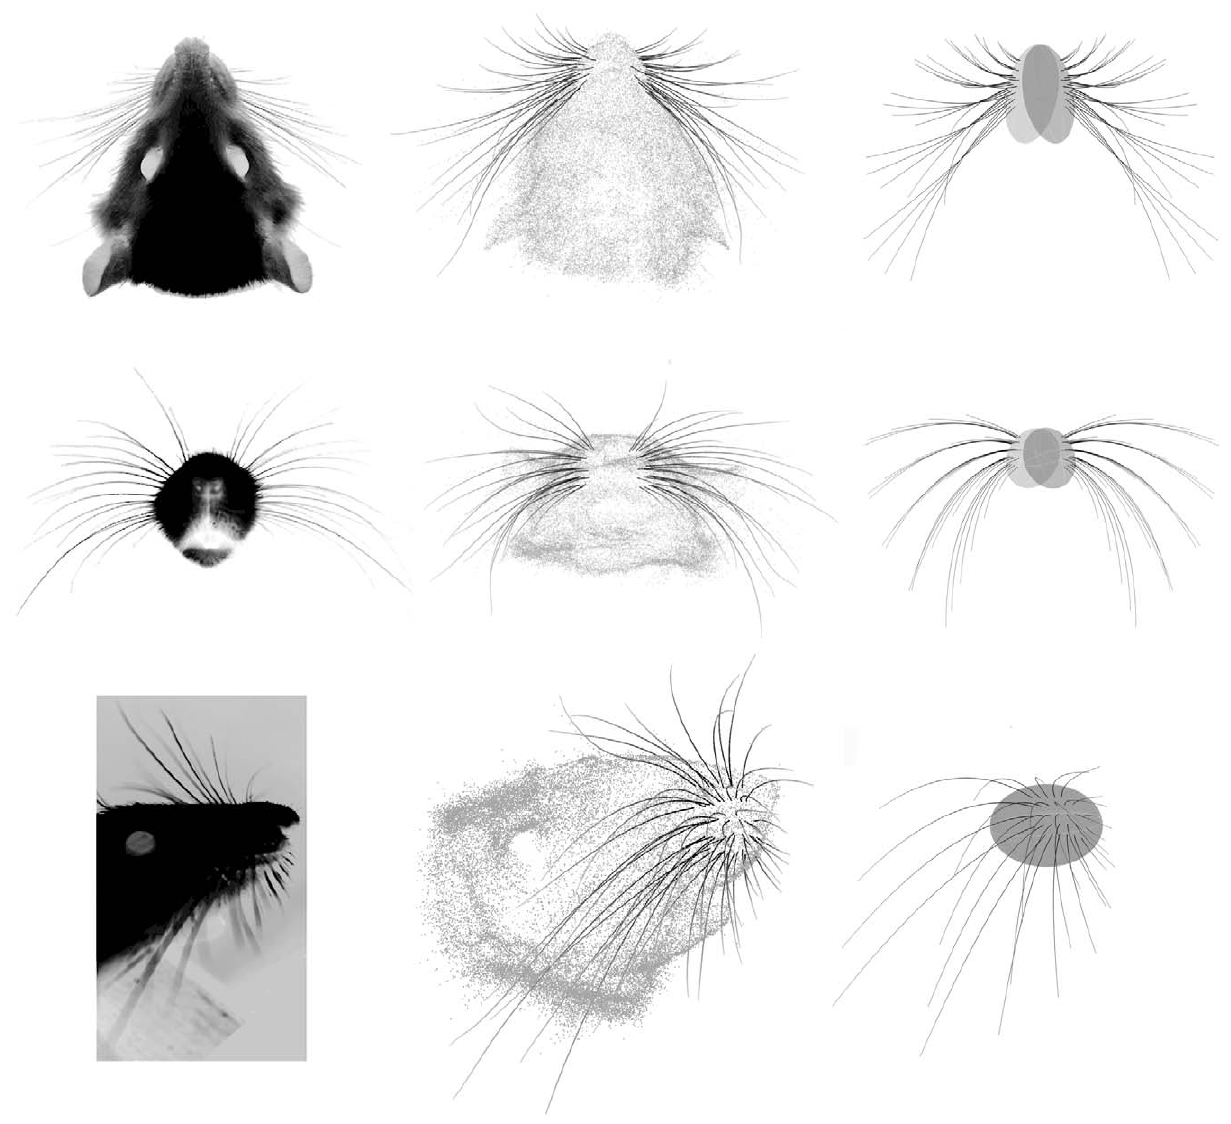
Figure 9. Comparison between photographs of the vibrissal array, 3D scans of the vibrissal array, and the model of the vibrissal array. Care was taken to ensure similar head orientations for all images within a row. ( Left column ) Photographs of an anesthetized rat. ( Middle column ) Scanned 3D images of another rat. ( Right column ) Model of the vibrissal array generated from the parameter values in Table 2, equations in Table 3, and equation